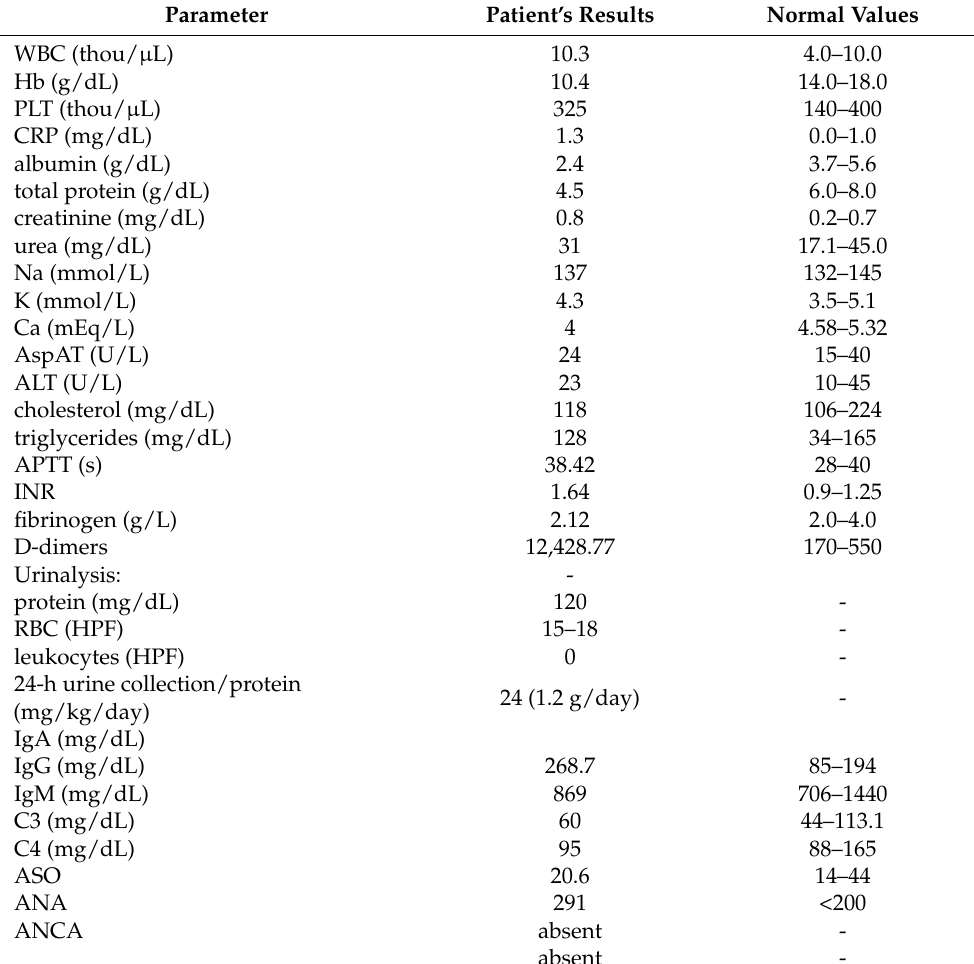
Table 1. Laboratory workup on